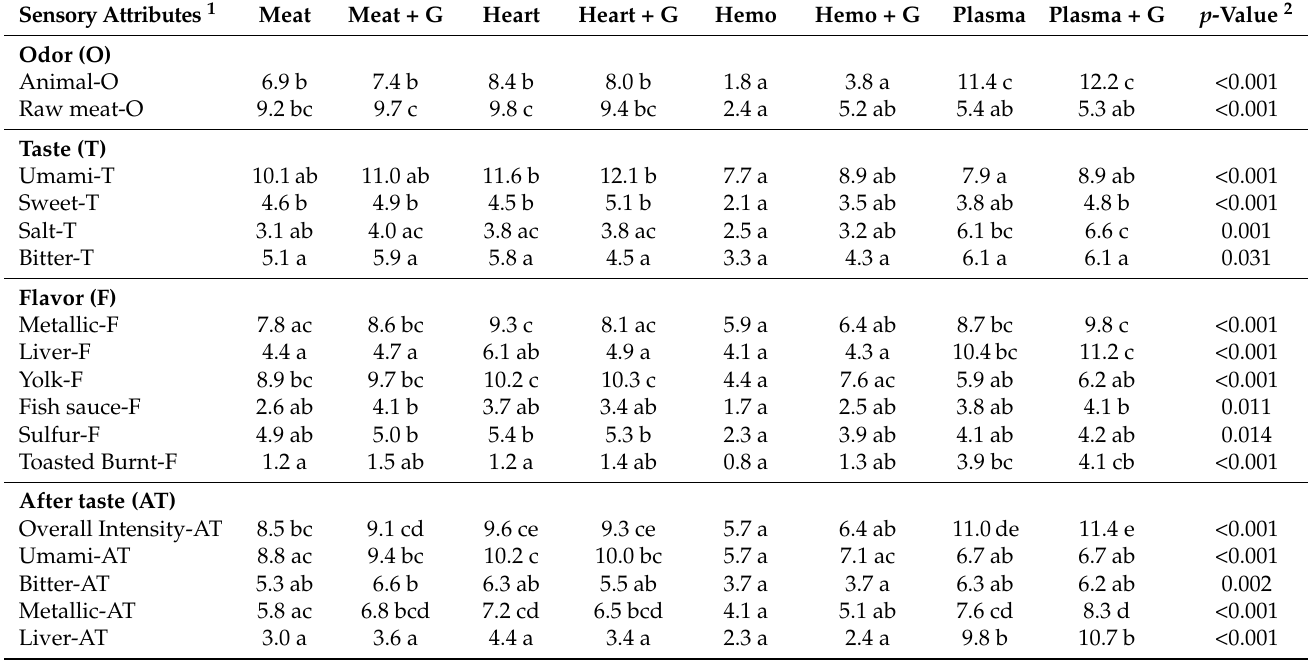
Table 2. Panel mean intensity scores of the sensory attributes for the hydrolysates rated on a 15-cm unstructured line scale, with p -values and suffixes (a, b, c, d, e) annotating sample differences. G indicates glucosamine